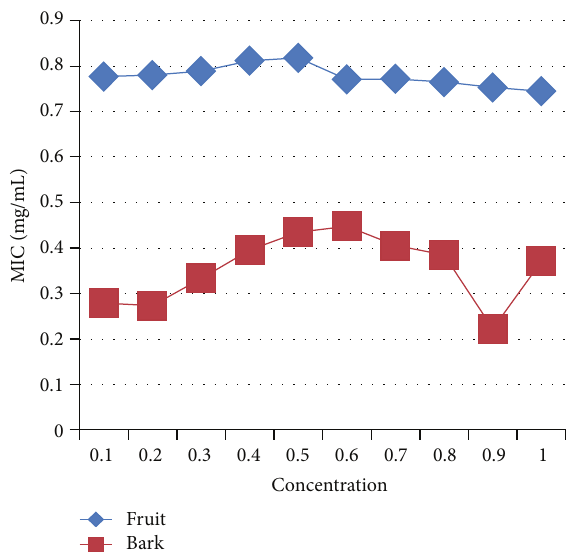
Figure 12: MIC values (mg/mL) exhibiting potential of bark and fruit of C. ambrosioides against B. subtilis .